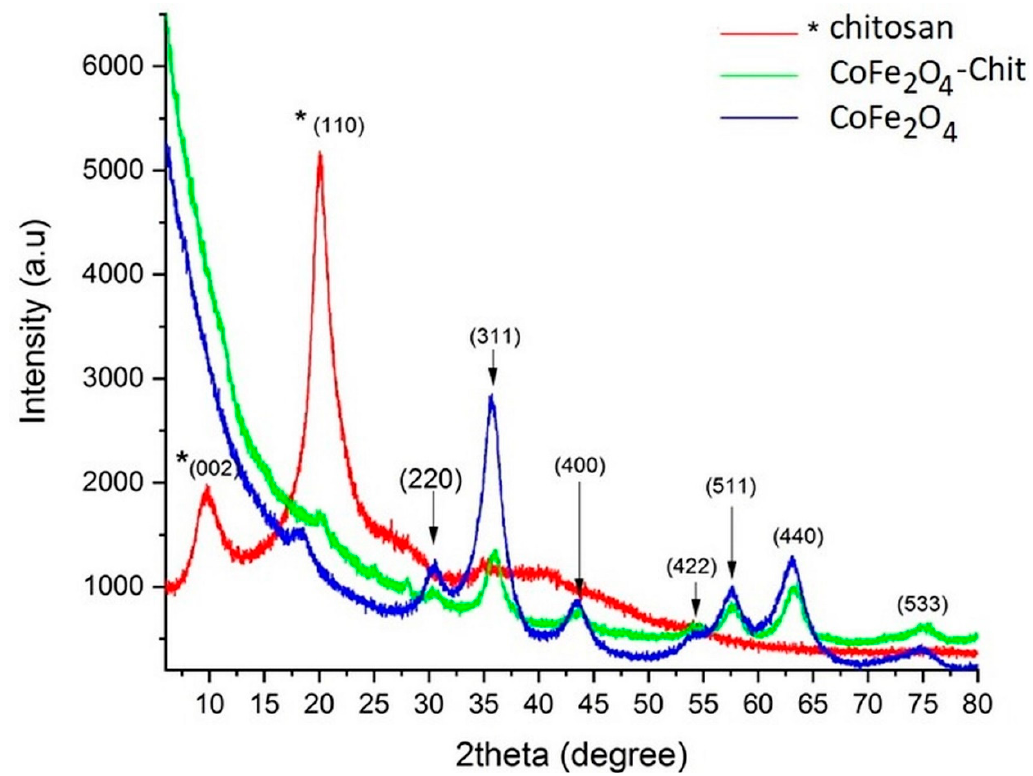
Figure 4. X-ray diffractograms of CoFe 2 O 4 , CoFe 2 O 4 –Chit, and Chitosan. In the above diffractograms the families of crystalline planes (220), (311), (400), (511), (440) were identified corresponding to the cobalt ferrite CoFe 2 O 4 , (JCPDS no. 01-080-6487) metal oxide with a spinel-type structure that crystallizes in the cubic system, having the network constants a = b = c = 8.381 [Å] and cell Vol = 588.69 [Å 3 ]. In the case of our CoFe 2 O 4 sample, the network constants a = b = c = 8.344 (6) and Vol = 580.84 and an average crystallite size were calculated with the Debye–Scherrer formula of approximately 4 nm (the average crystallite size was calculated using the Full with at Half Maximum (FWHM) value corresponding to three diffraction maxima, after drawing a baseline and approximating the graph with the pseudo-Voigt function).